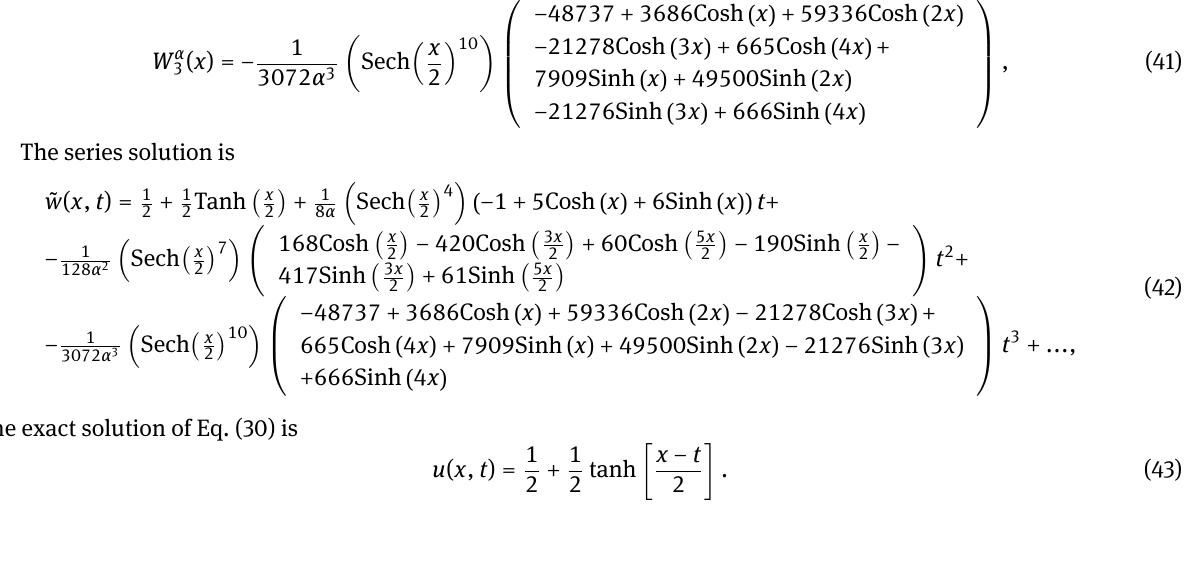
Table 2: Numerical analysis of solution Eq. (37), (42) and exact solution (43) for example 2 at α